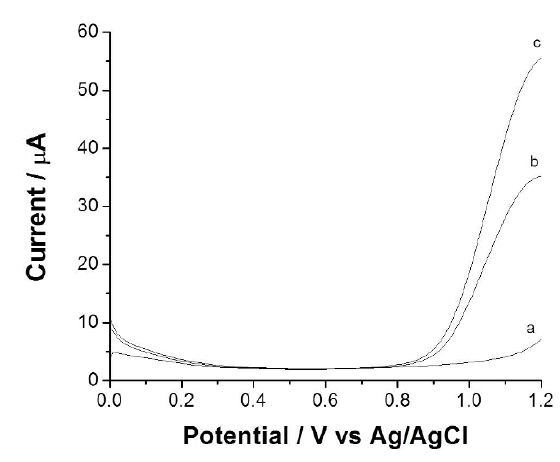
Figure 1. Square wave curves recorded with a composite electrode in phosphate buffer (pH = 8.0) before (a) and after (b, c) addition of 2 and 4 mmol L -1 ethambutol solutions, respectively (final concentration in solution). Frequency = 10 Hz, amplitude = 50 mV and step = 10